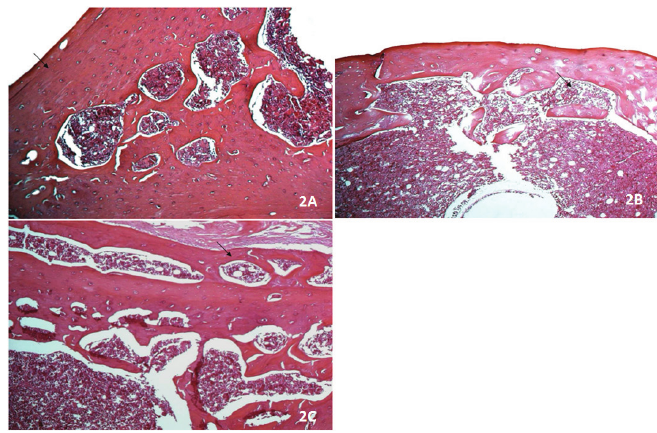
TABLE 1 - Comparison of mean new bone formation scores obtained at different time points for the three groups (Kruskal-Wallis nonparametric